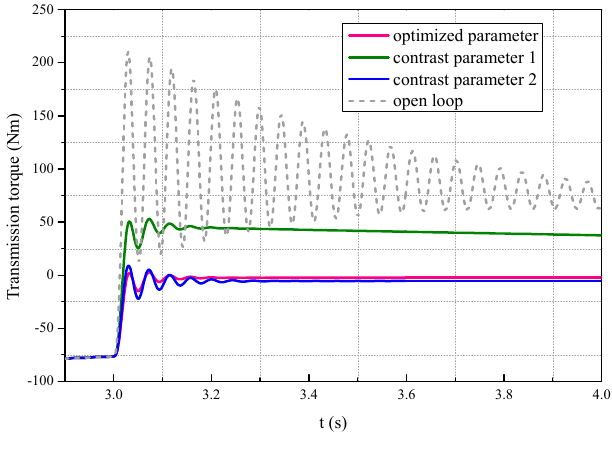
Figure 13. Transmission torque τ .